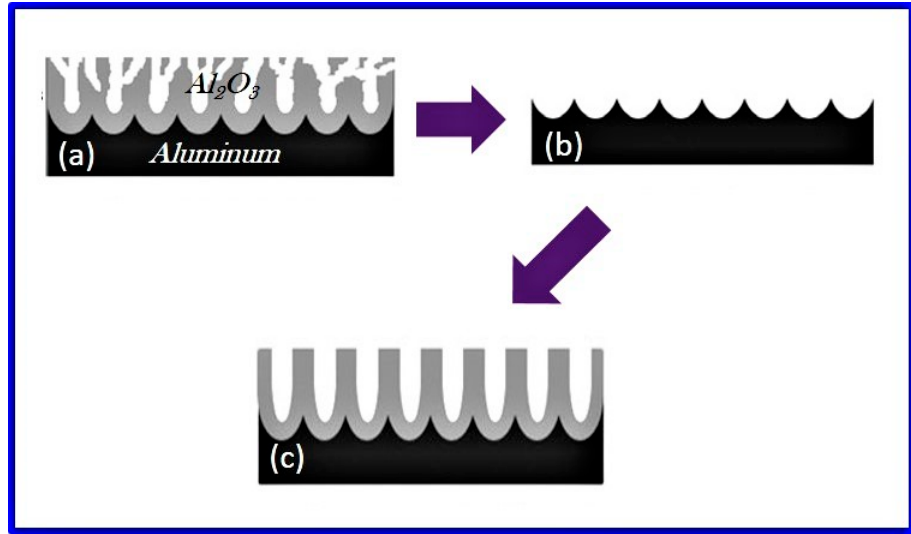
Figure 8. Two-step anodization process: The first-step anodization yielding irregular pores at the top surface ( a ); The removal of the first-step oxide giving concave dimples on the metal surface ( b ); and the second-step anodization leading to self-organized, well-ordered nanopore arrangement of NAA ( c ).